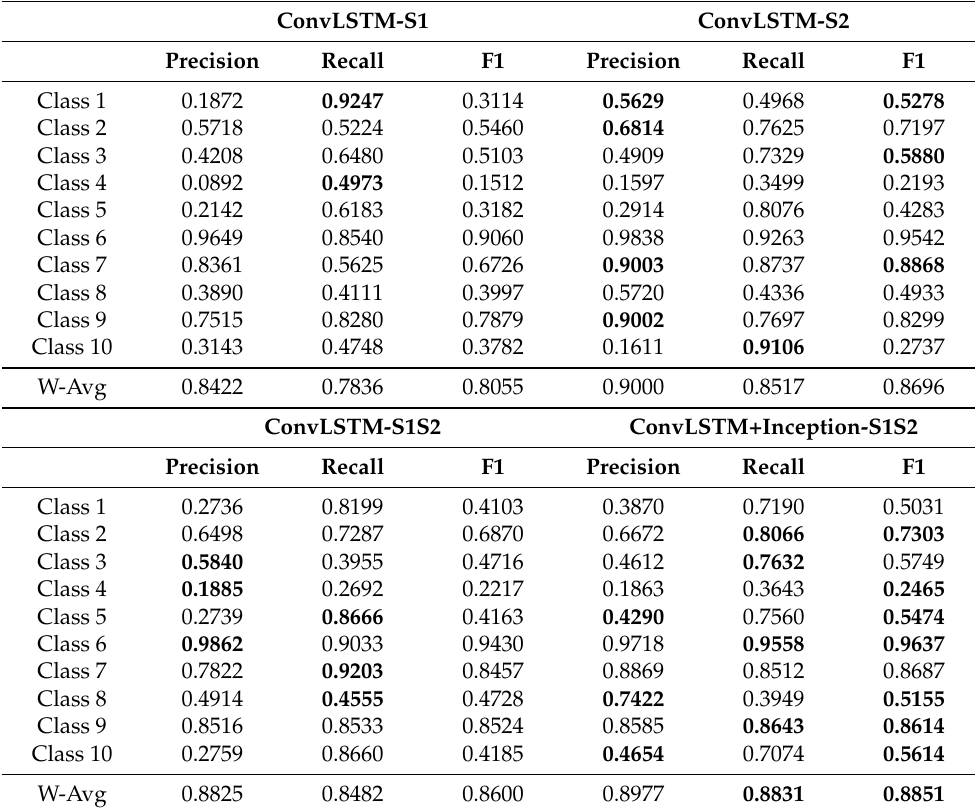
Table 7. Results of all methods for the test zone located in the west of the Grand-Est region (In bold the higher value for each metric and for each method).